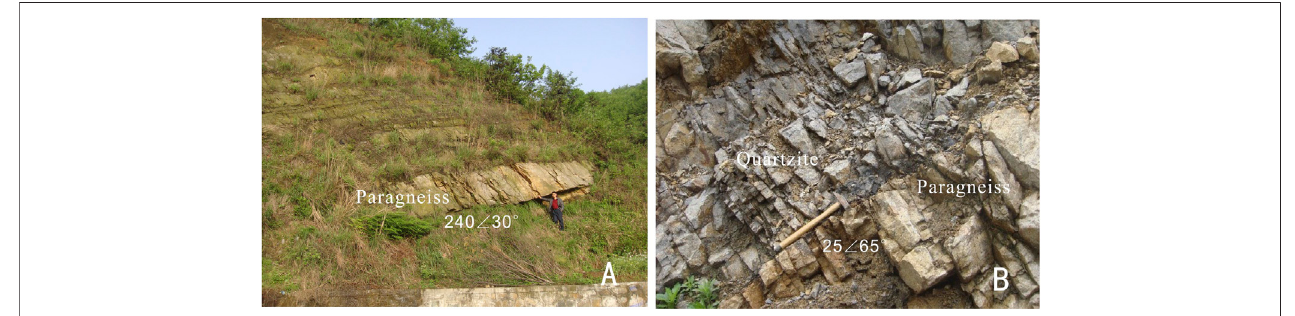
FIGURE 2 | Outcrops of paragneiss in the north of Xinxian county (A) and in the Xinxian Qianhe quarry (B) .